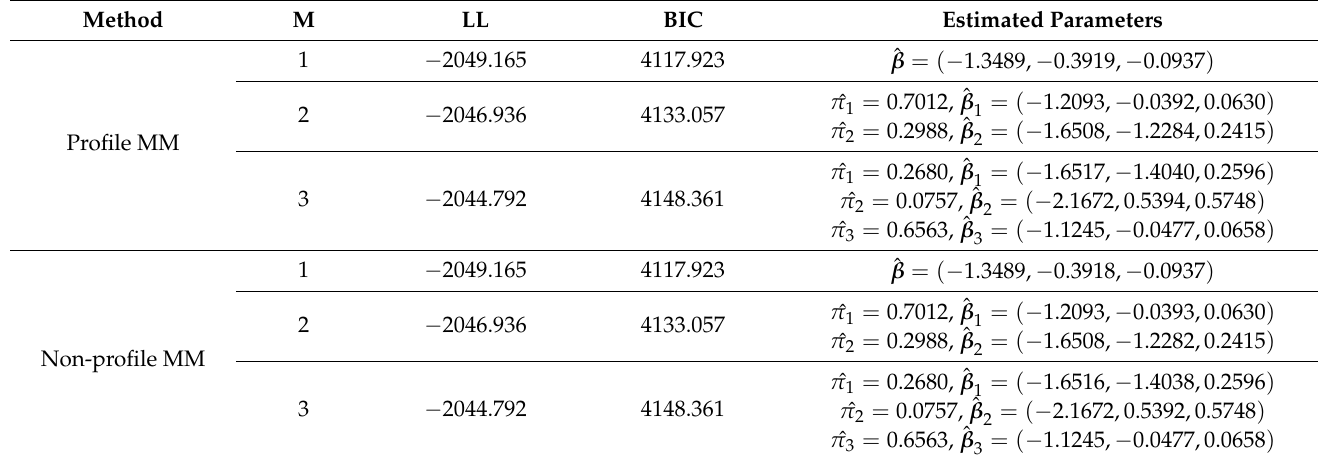
Table 7. Estimation results for breast cancer